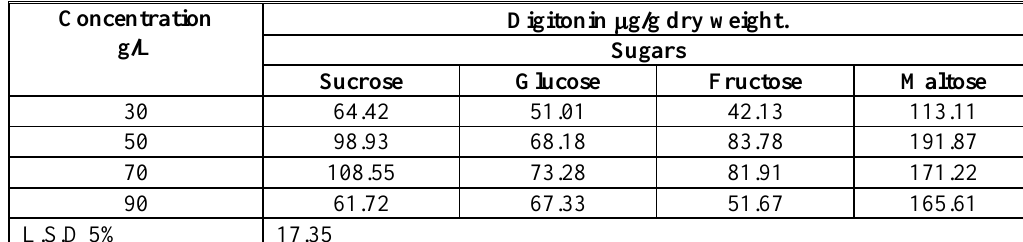
Table 4 :- Effect of different concentrations of sugars with the presence of 0.5 mg/L TDZ and